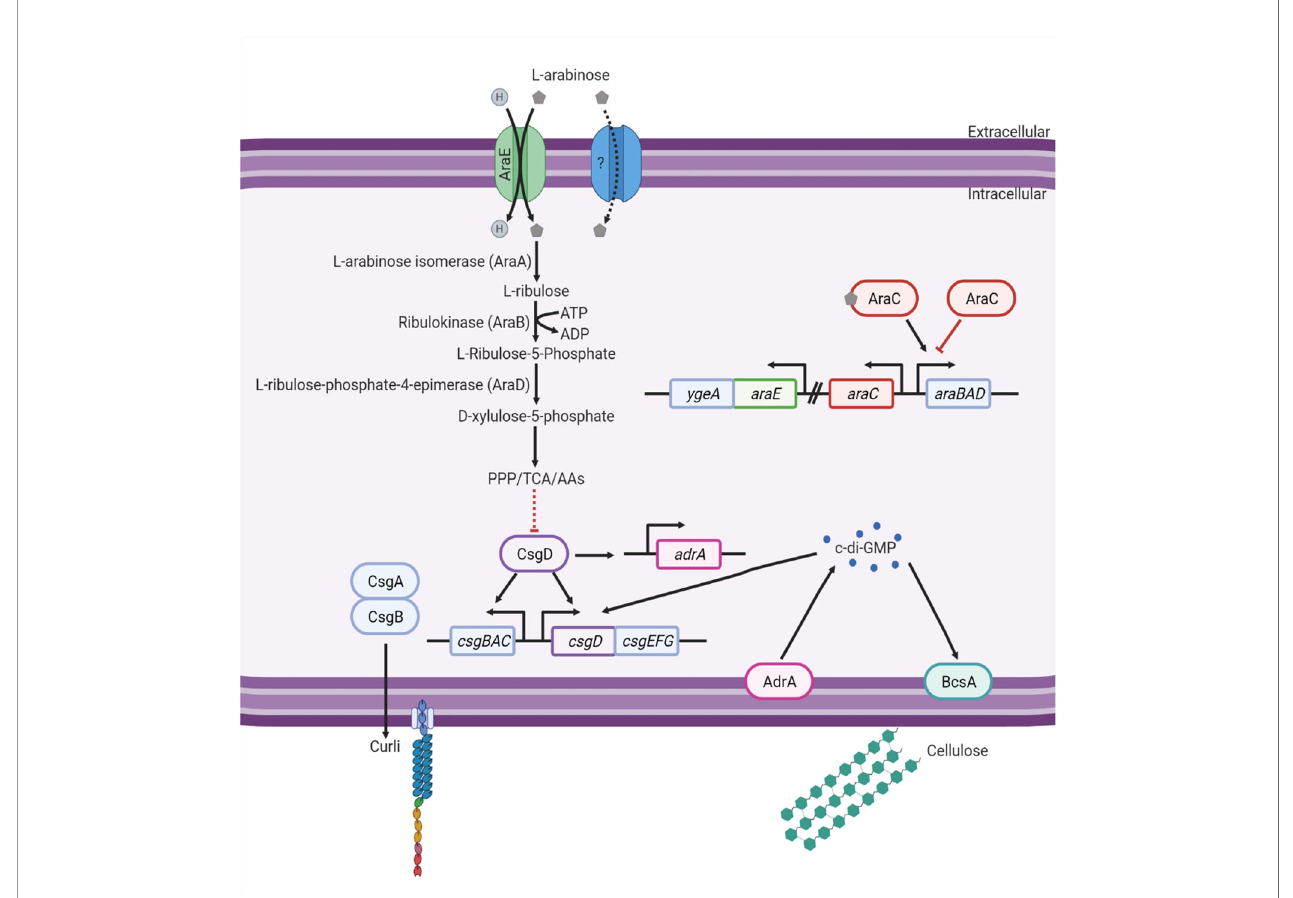
FIGURE 8 | Model of the effect L-arabinose metabolism has on bio fi lm signaling. Created with